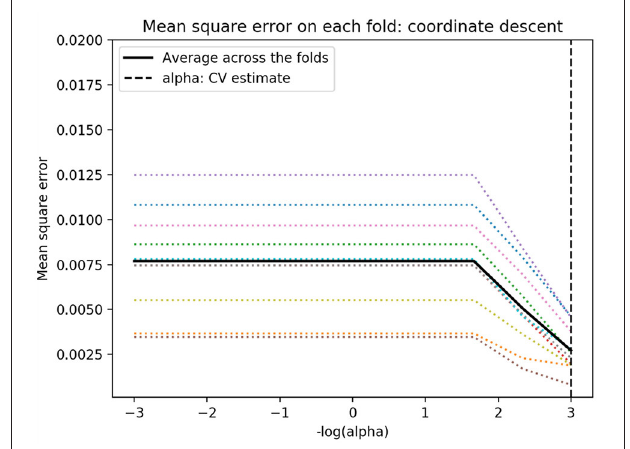
FIGURE 2 | Comparison of model prediction performance. TABLE 5 | The related importance of